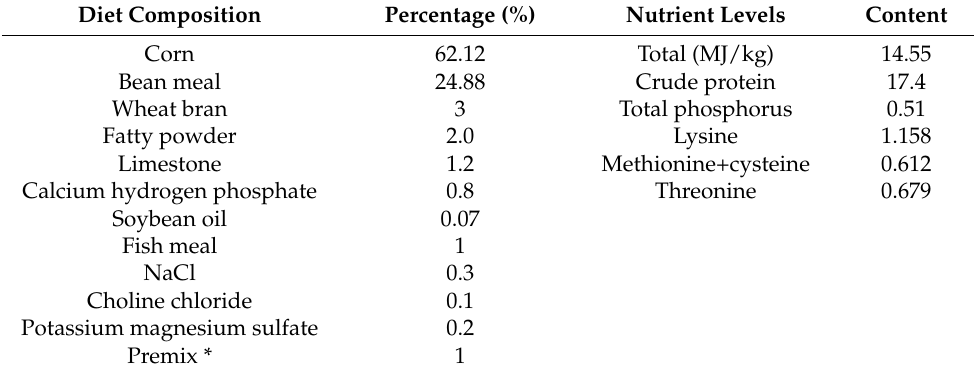
Table 4. Composition and nutrient levels of the basal